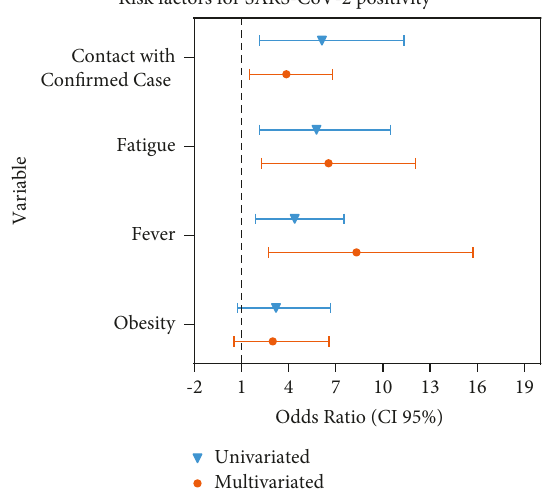
Figure 3: Forest plot of the univariate and multivariate weighted odds ratios with propensity score matching of the risk factors for SARS-CoV-2